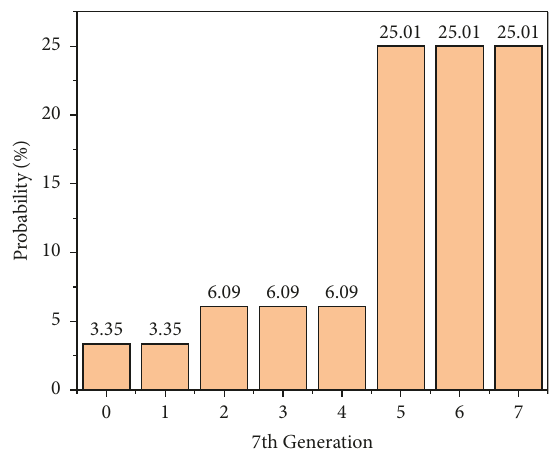
Figure 1: Change trend of probability in generation7.